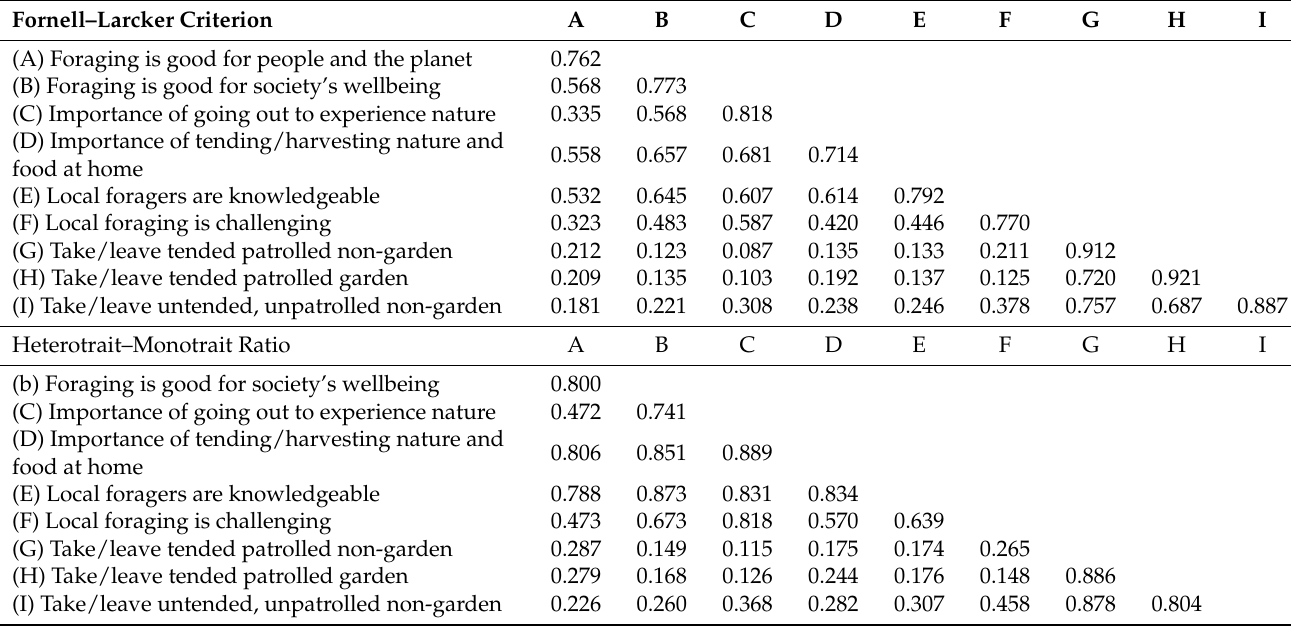
Table 3. Scale Discriminant Validity.